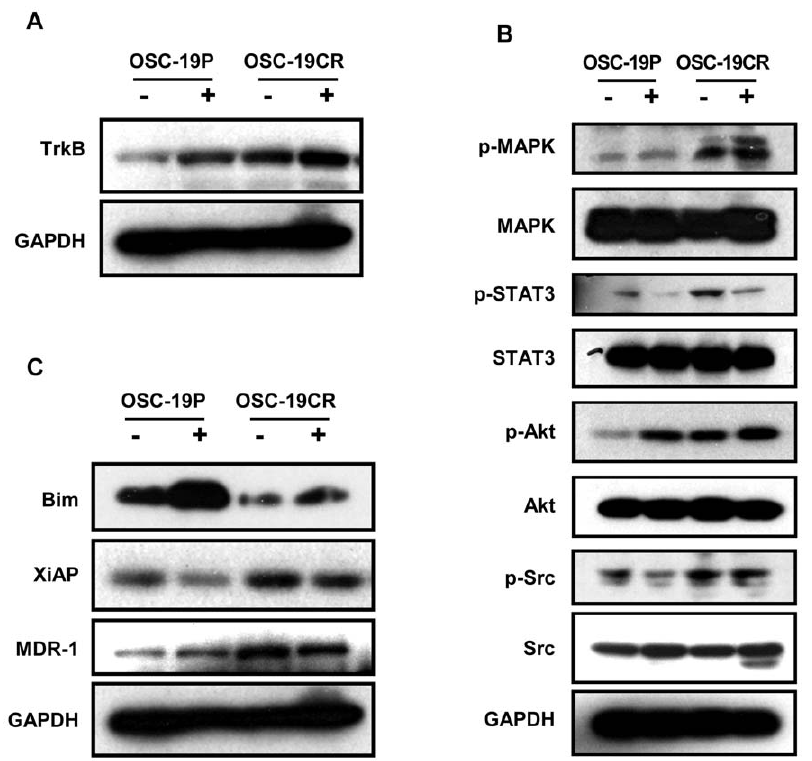
Figure 3. Differential response of OSC-19P and OSC-19CR to CDDP. Cell lysate was collected following 5 uM of CDDP and separated with SDS-PAGE gel. Membrane was then incubated with indicated antibodies. A . Expression of TrkB was determined in both OSC-19P and OSC-19CR following 5 uM of CDDP treatment. B . Phosphorylation of Akt, Src, MAPK, and STAT-3 was determined following 5 uM CDDP treatment. Levels of phosphorylated kinases were normalized with expression of total kinases. C . 5 uM of CDDP modulates expression of Bim, XiAP, and MDR1. Expression levels of Bim, XiAP, and MDR1 were determined by Western blot analysis.